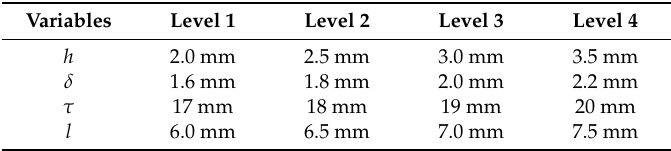
Table 7. Levels of the structural parameters.